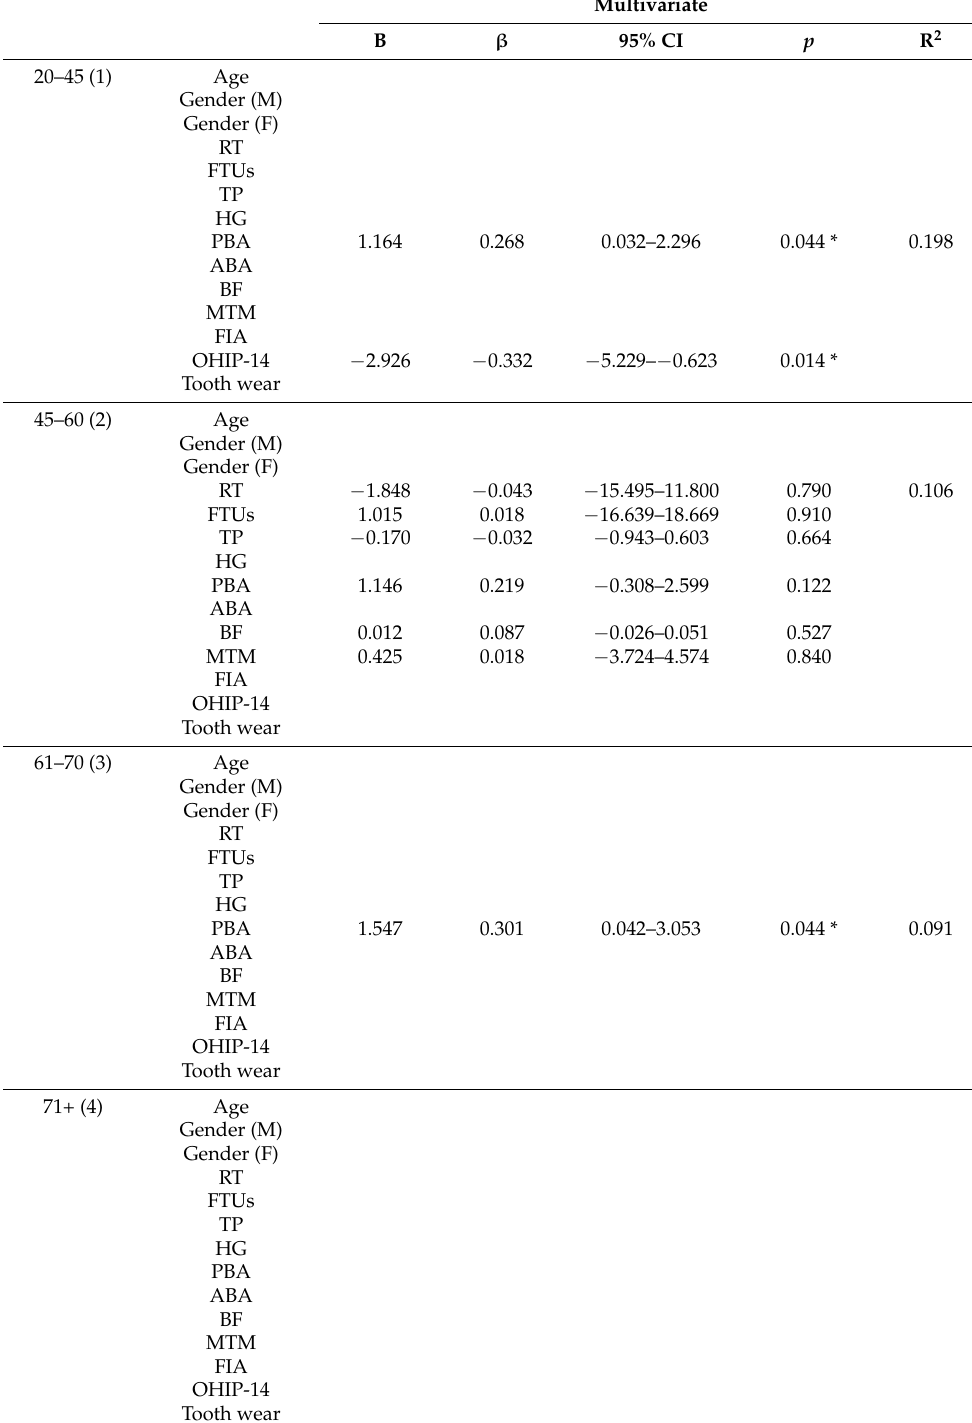
Table 4. Multiple linear regression analysis of factors associated with masticatory